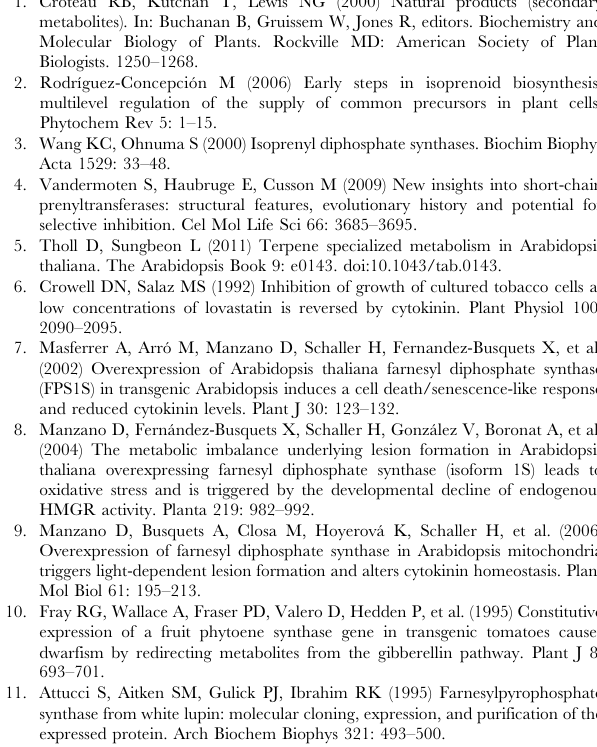
Figure S1 Predicted secondary structure of the region containing the AUG translation initiation codon of the FPS2::FPS1S, FPS2, and FPS2::FPS1S-mutdis mRNAs. Secondary structure models were generated by using the RNAfold web server (http://rna.tbi.univie.ac.at/). The AUG start codons are marked with an oval. (TIF) Figure S2 Normal embryo development in fps2-1 mu- tant seeds. Seeds with embryos at the indicated developmental stages were fixed and cleared for visualization as previously described [26].